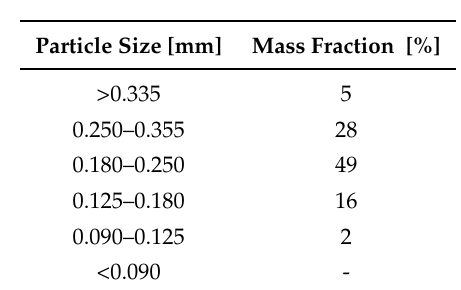
Table 2. Particle size distribution of F32 Quartz sand